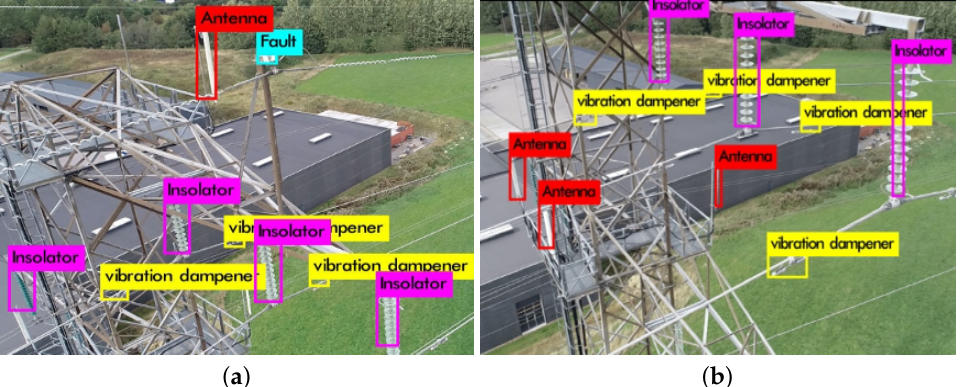
Figure 12. Detection results of different components of power line pylons based on YOLOv3- darknet53.